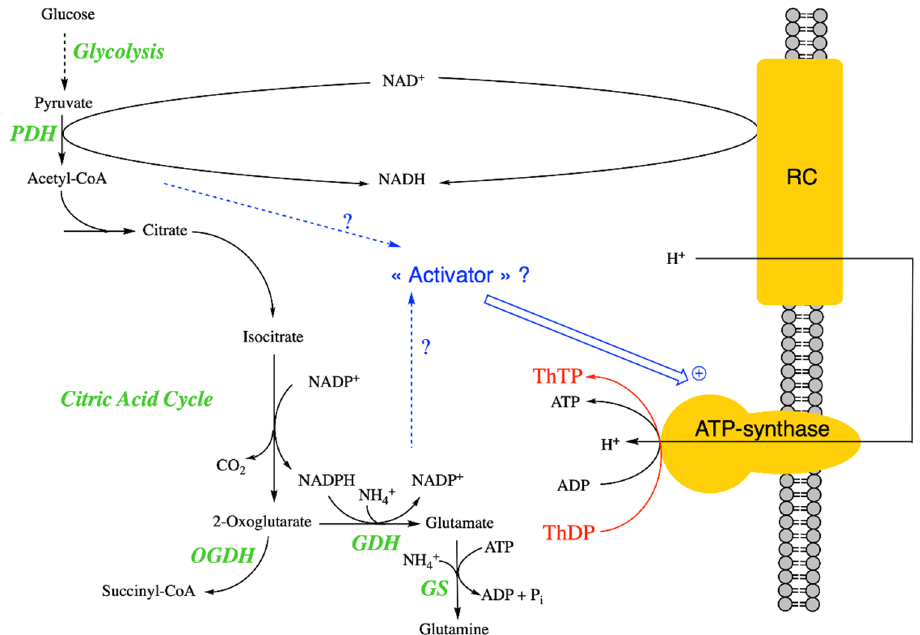
Figure 3. Mechanism of ThTP synthesis in E. coli and possible regulation. It seems that ThTP synthesis by a chemiosmotic process requires an activator synthesized either during the early reactions of the Krebs cycle or after the branching point towards glutamate and glutamine. ThTP synthesis by AK is negligible in E. coli under these conditions. Note that E. coli isocitrate dehydrogenase requires NADP + and not NAD + as co-substrate [48] (PDH, pyruvate dehydrogenase; GDH, glutamate dehydrogenase; GS, glutamine synthetase).